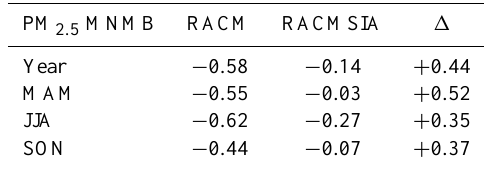
Table 15. Comparison of MNMB statistics between MOCAGE sim- ulations (RACM and RACMSIA) and AIRBASE data over Europe for PM 2 . 5 according to different